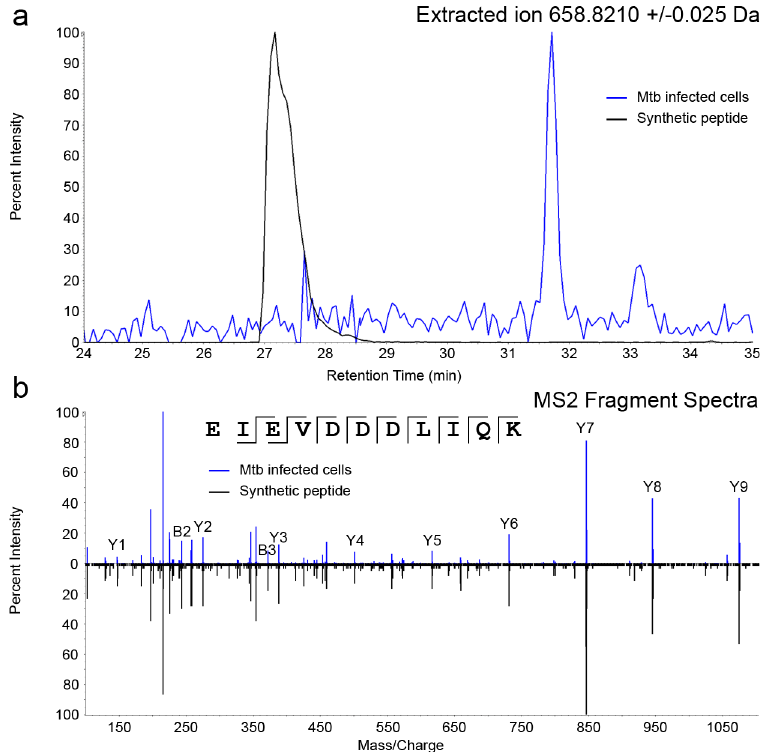
Fig 4. An Mtb ligand derived from Rv0634Ais eluted from sHLA-E molecules. A) Extracted ion chromatogram of ion 658.8210(EIEVDDDLIQK) in Mtb infected ligandpool (blue trace) and synthetic peptide (black trace). B) AnnotatedMS2 fragment ion spectra for the identified Mtb peptideEIEVDDDLIQK in Mtb infected ligandpool (blue trace) and synthetic peptide(black trace).